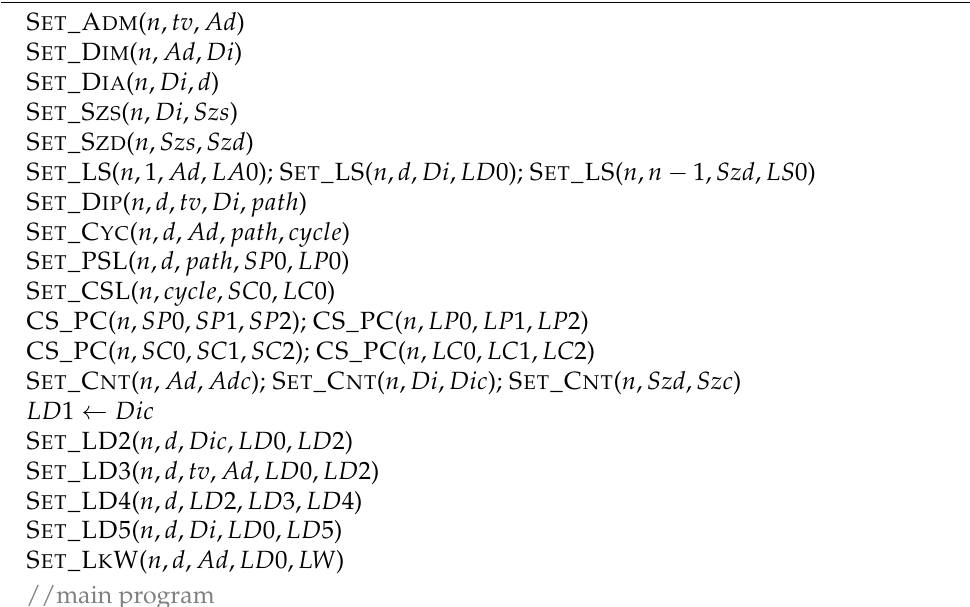
Algorithm A18 Use of the above